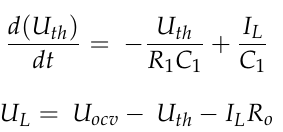
Figure 5. ECM with an open circuit voltage source, an ohmic resistance with n RC pairs in series.